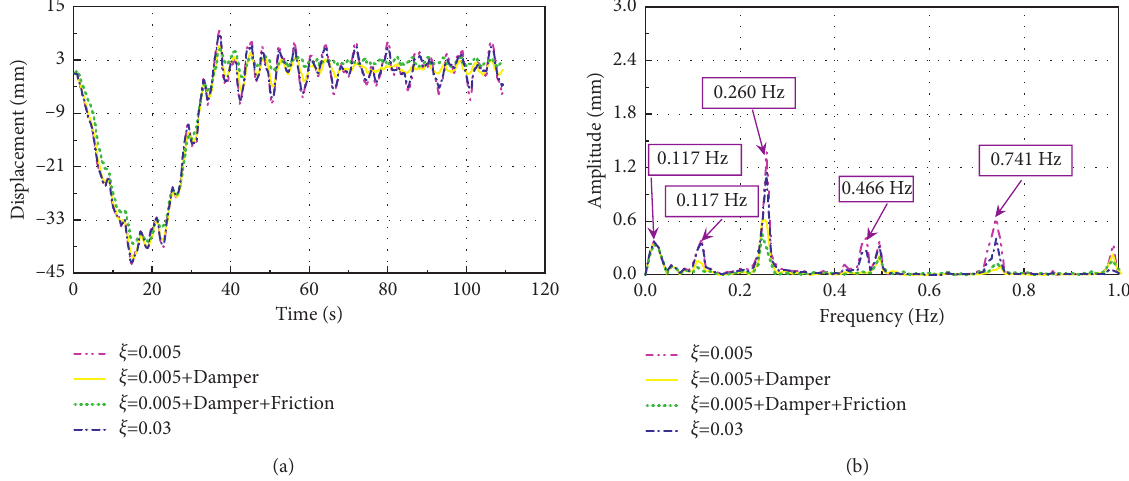
Figure 18: Girder end longitudinal displacement of the suspension bridge under a series of moving loads at 25m/s: (a) time history of longitudinal displacement; (b) Fourier spectrum of longitudinal